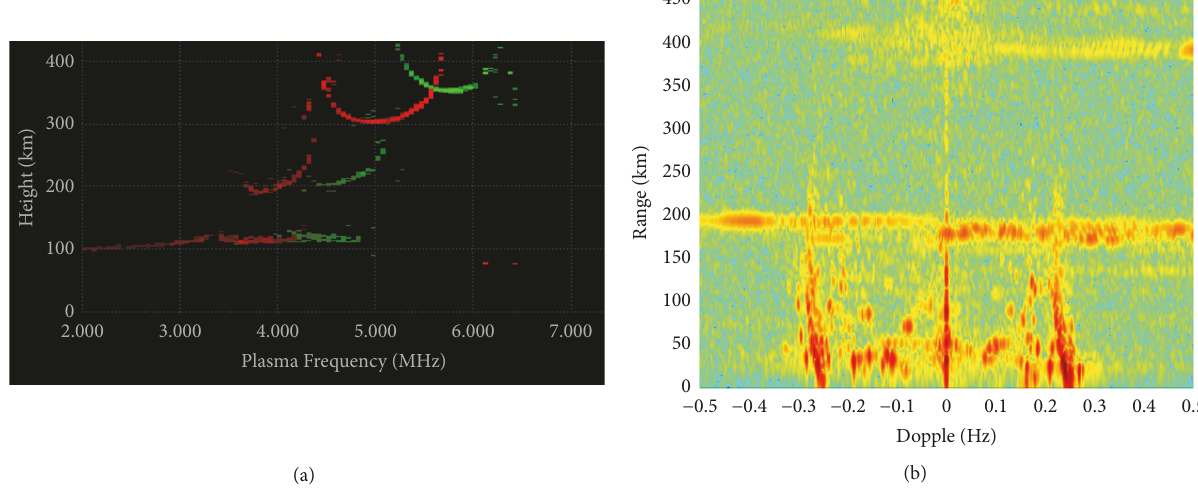
Figure 2: The comparison of ionogram and RD spectrum on 10:53 am, June 28, 2018, location: Weihai (37.5 ∘ N, 122 ∘ E), China. (a) Ionogram (the horizontal axis is the plasma frequency and the vertical axis is the virtual height). (b) RD spectrum.